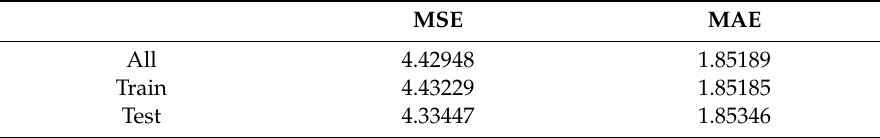
Table 4. Metrics for the artificial neural network (ANN) regression model for cost.